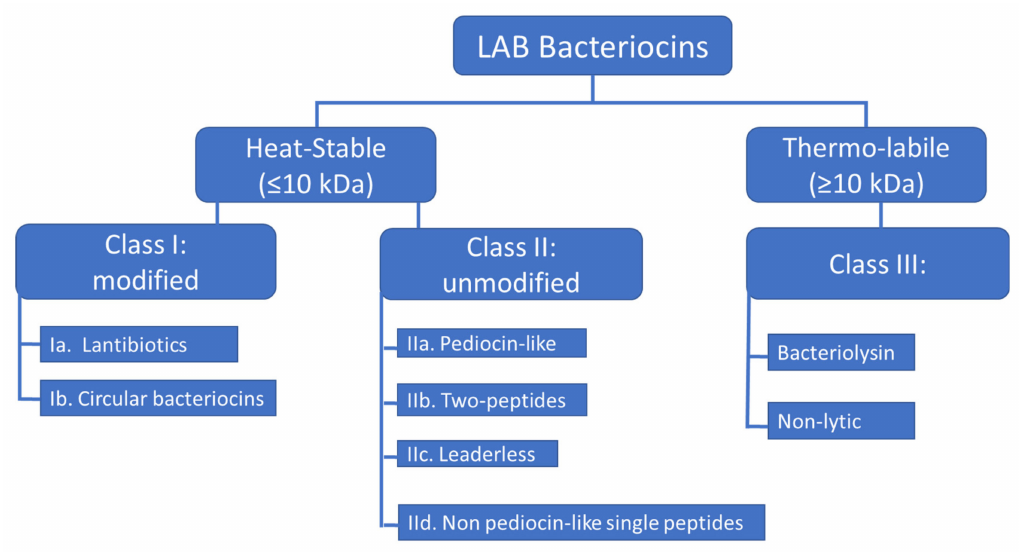
Figure 1. Suggested classification scheme for LAB-bacteriocins, adapted from Alvarez-Siero et al.